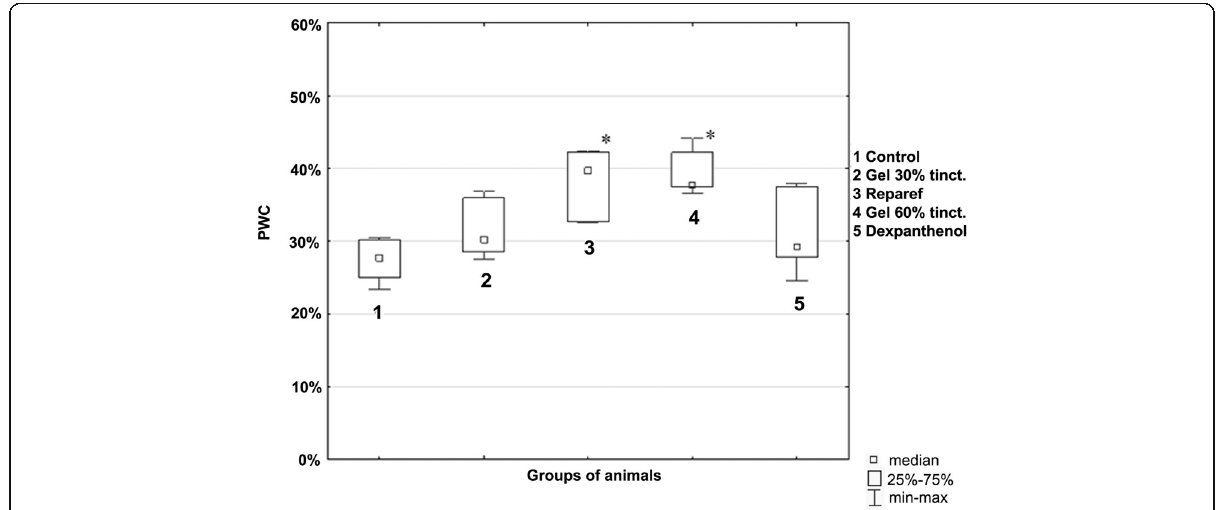
Fig. 1 Percentage of wound closure per day 5. * p < 0.05 vs control